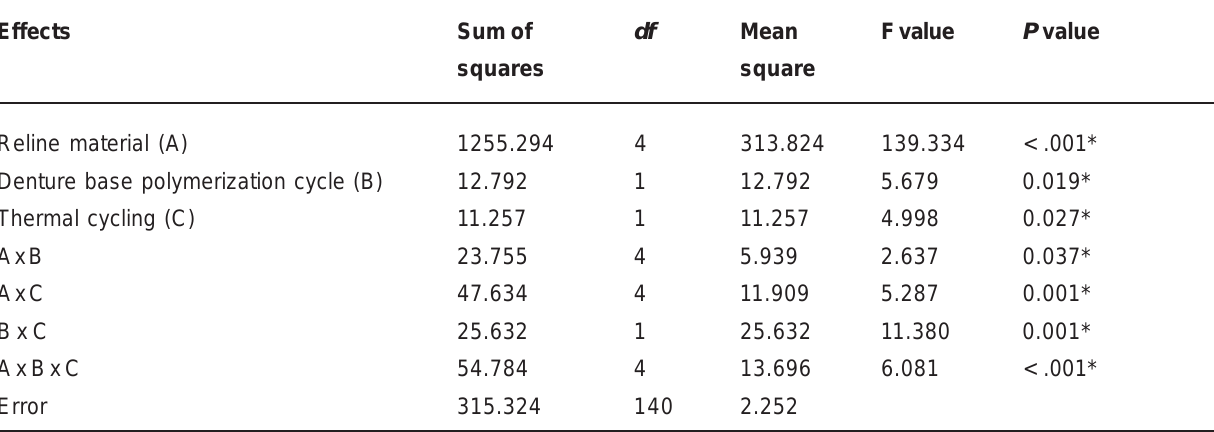
*Significant difference at P